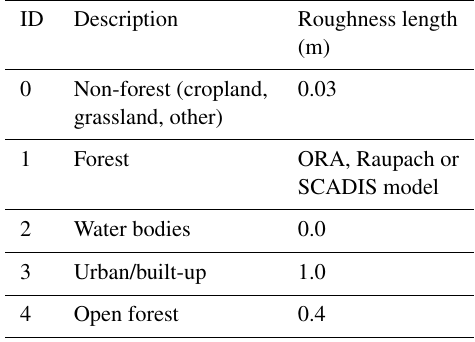
Table A5. Land cover table used for the Sentinel-based